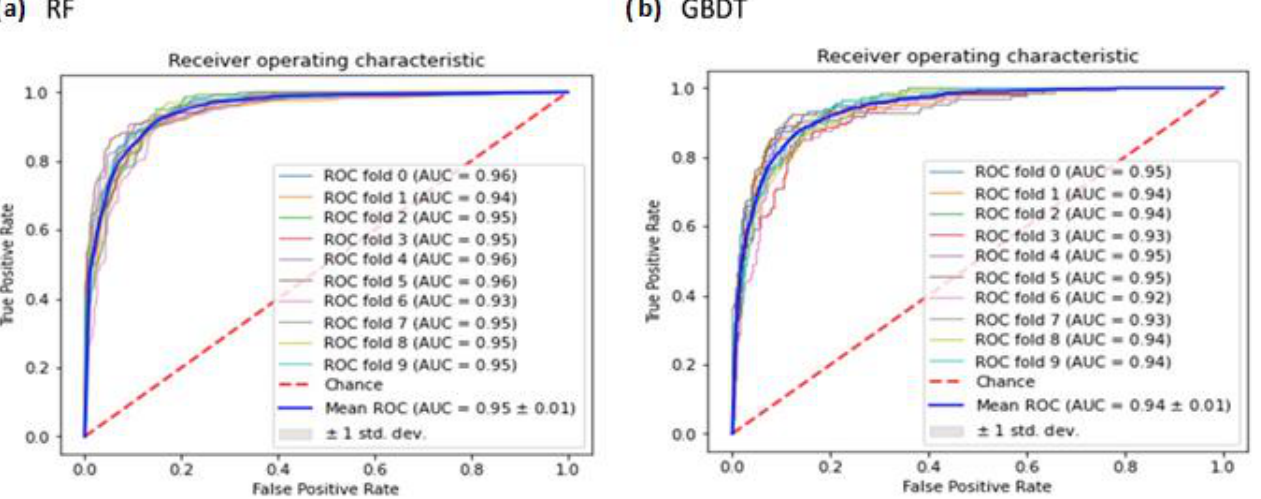
Figure 3. Comparison between ROC curves showing the best results achieved when the entire set of features is used. ( a ) The left ROC curve corresponds to the RF classifier, and ( b ) the right curve corresponds to the GBDT classifier. Each curve denotes one-fold of the 10-fold cross-validation, and the area under the curve (AUC) is displayed for each fold in the figure legend. The mean AUC is computed for the 10-fold.